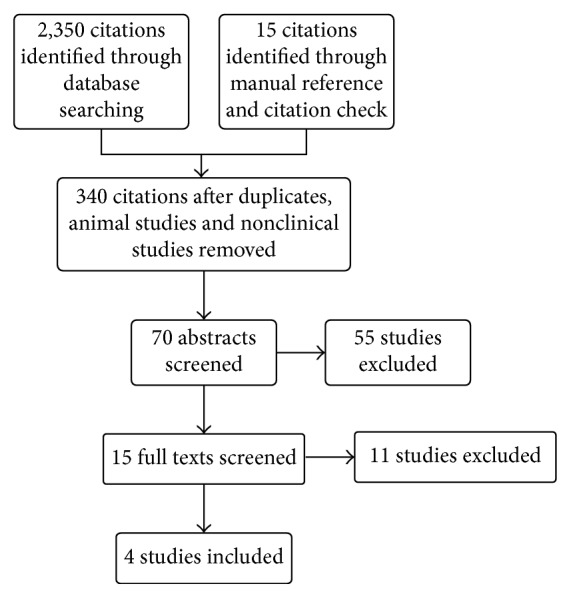
Study flow diagram.